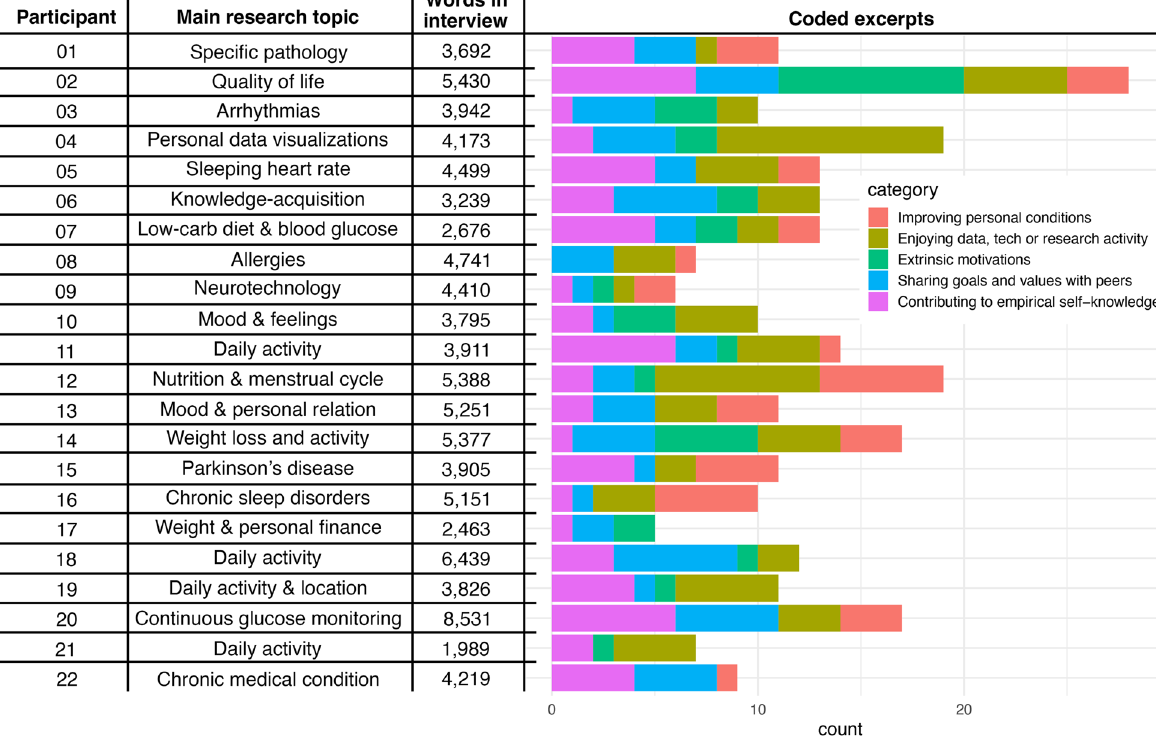
Fig. 2 Overview of the participants and coded excerpts. The distribution of the fi ve codebook categories in interview excerpts alongside participants ’ research topics and word counts per